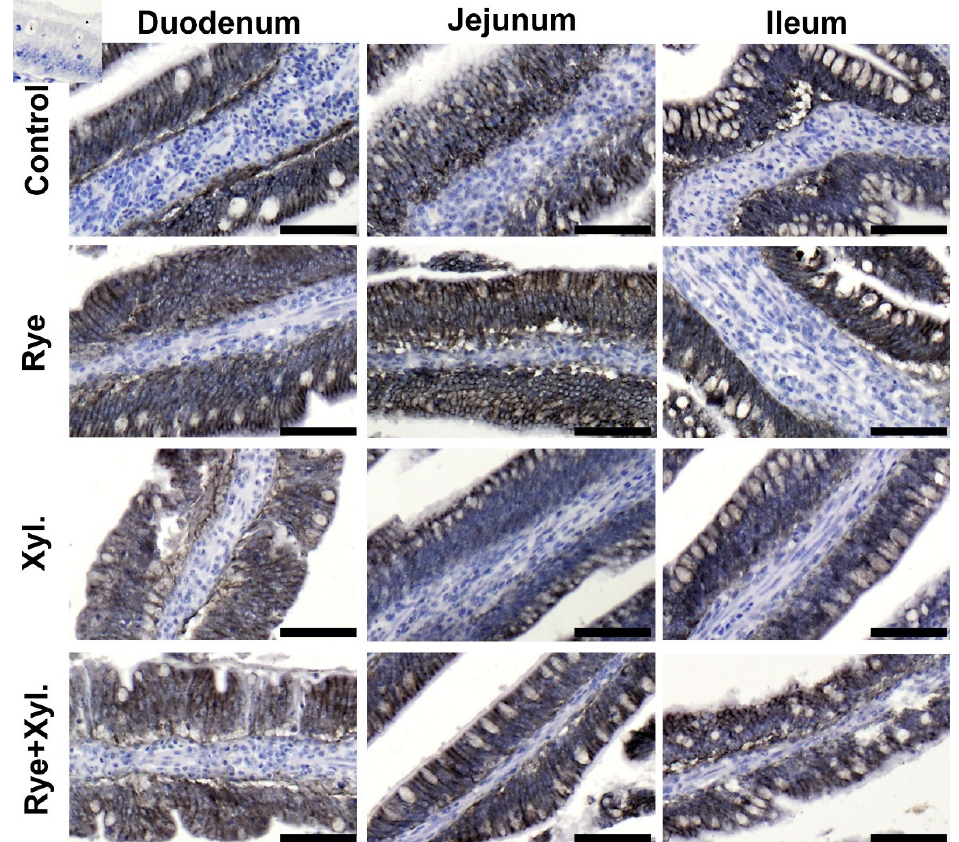
Figure 1. Epithelial expression and spatial distribution of Claudin 3 in the villi epithelium of the assessed intestine part. Control (0% rye inclusion, 0 mg/kg of feed xylanase supplementation), Rye (20% rye inclusion, 0 mg/kg of feed xylanase supplementation), Xyl. (0% rye inclusion, 200 mg/kg of feed xylanase supplementation), Rye + Xyl. (20% rye inclusion, 200 mg/kg of feed xylanase supplementation). Black staining localizes the examined protein. Upper left corner insert—antibody control. Scale bars represent 100 µm.